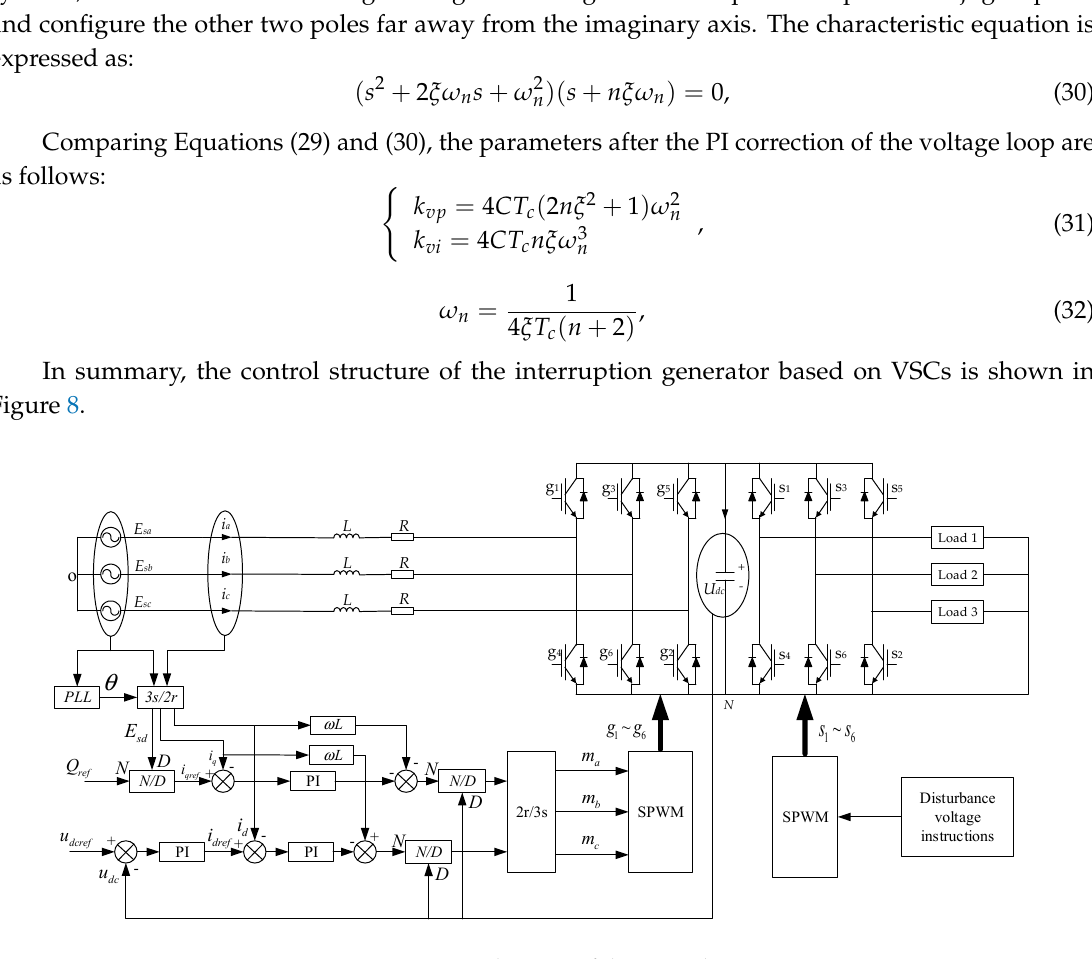
50 Table 2. Parameters of the controller. PI Parameters of Current Loop